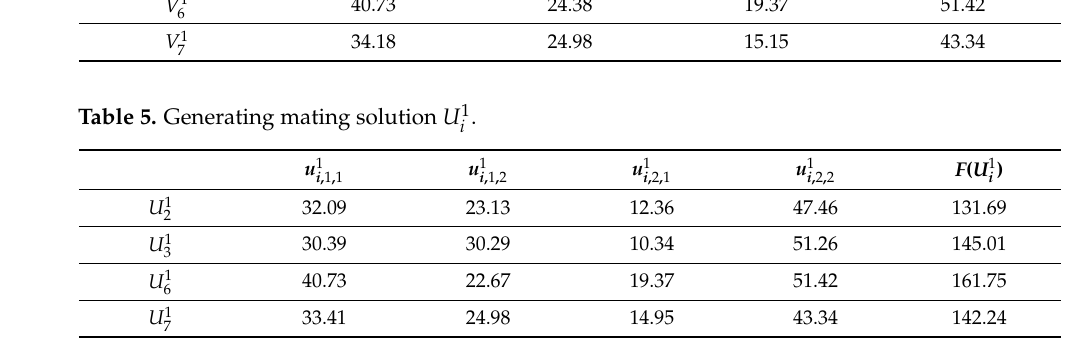
Table 6. Updating the solutions of this generation X 1